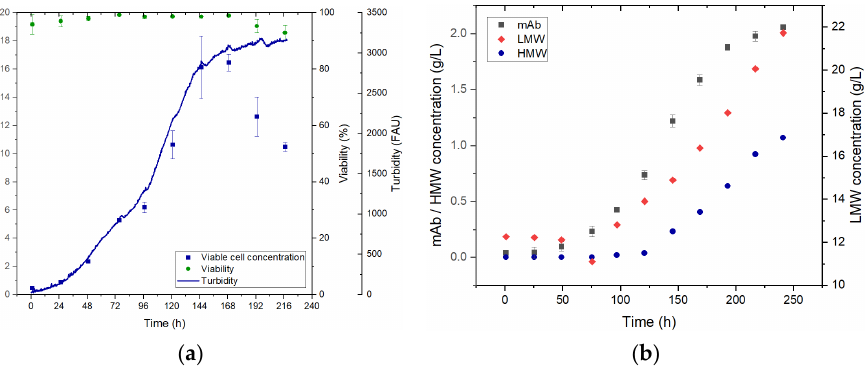
Figure 6. ( a ) Viable cell concentration, viability and turbidity over process time. ( b ) mAb concen- tration and HMW/LMW pseudo-concentrations over process